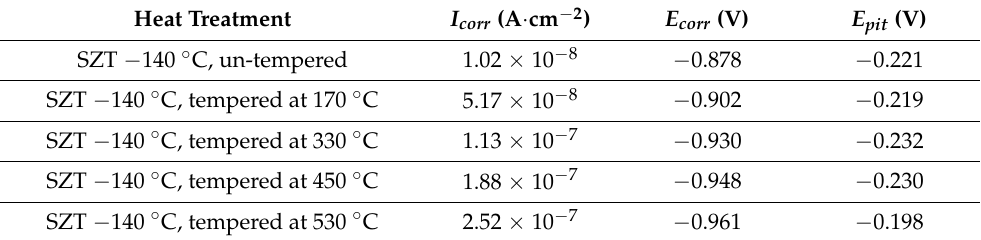
Figure 9. Potentiodynamic polarisation curves of Vanadis 6 steel subjected to SZT at − 140 ◦ C, in un-tempered state and in the states after different tempering treatments. Table 5. Corrosion current, I corr , corrosion potential, E corr , and pitting potential, E pit , values acquired from corrosion tests in 3.5 mass % NaCl water solution, for specimens after SZT at − 140 ◦ C and different tempering